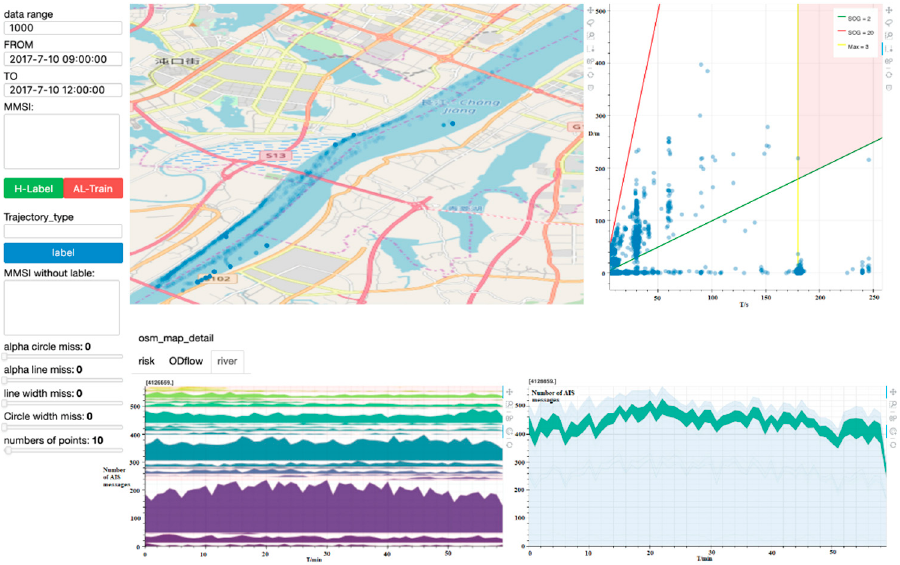
Figure 13. Analysis of the blind spots of a base station.